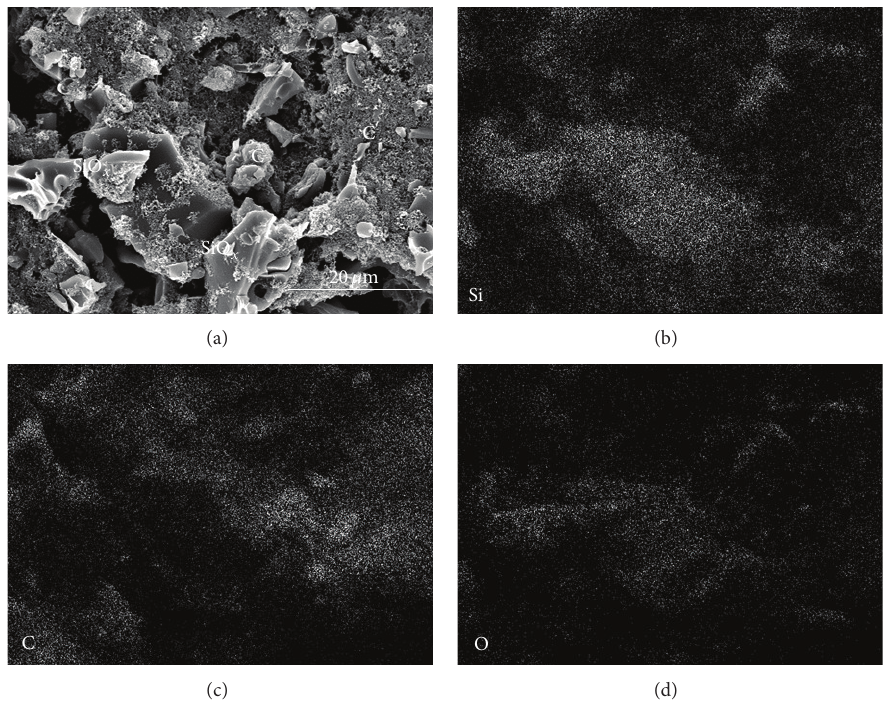
Figure 2: SEM photograph (a) with EDS analysis of Si (b), C (c), and O (d) elements for the surface of the anode electrode on copper foil substrate, prepared by mixing the synthesized composite of C and SiO 𝑥 particles with pitch carbon and conductive Ketjen and Super P carbon blacks.